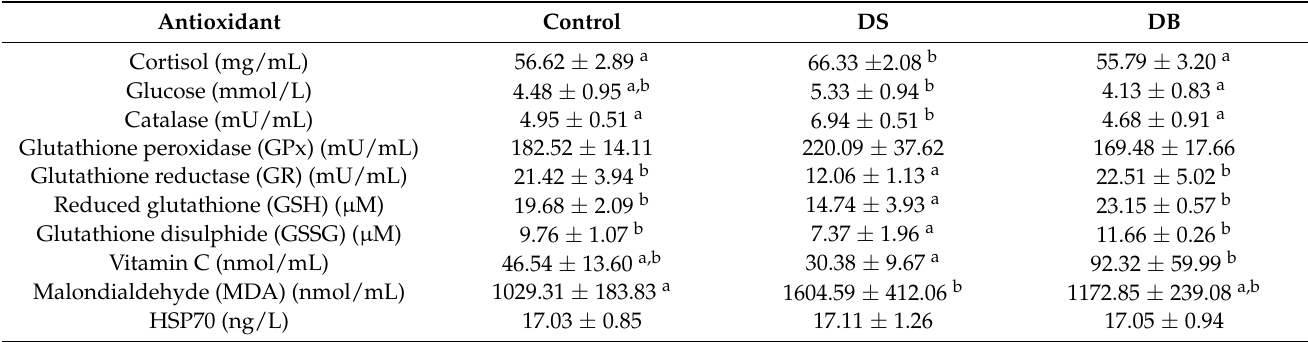
Table 2. Antioxidant and stress parameters of European perch ( Perca fluviatilis ) kept in dark-sided (DS) and dark-bottomed (DB) tanks for 8